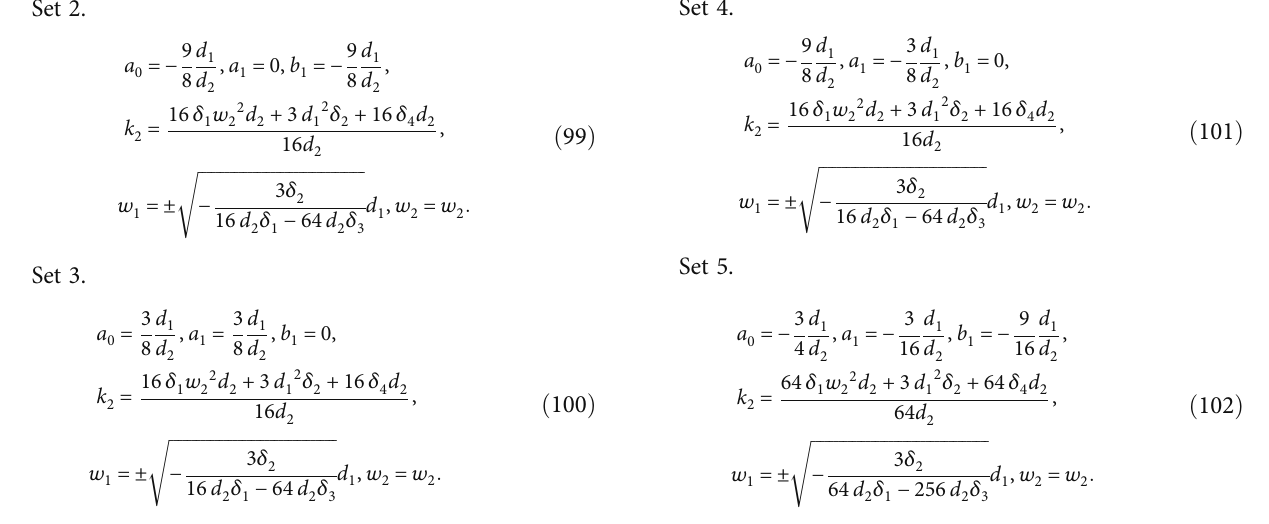
Figure 7: The graphical simulation representation of j U 9 = 0 : 6, w = 0 : 01 δ 4 2